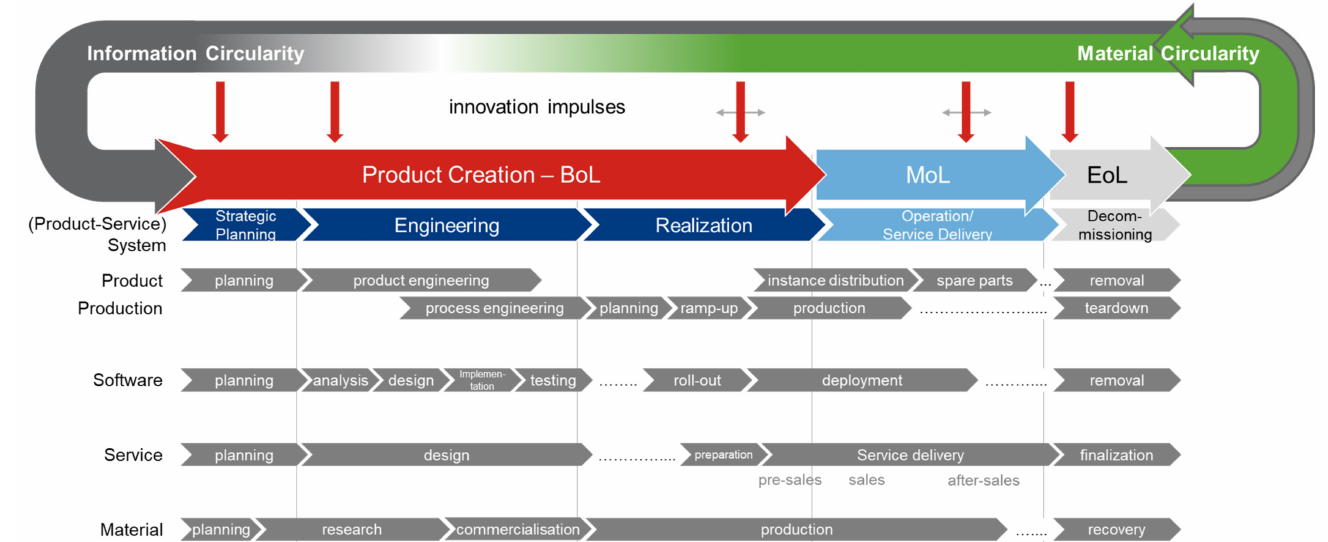
Figure 7. Alignment of technical disciplines and servicing under the hood of the Product Creation process, based on the intrinsic gPLC concept and extended by indications of material and information circularity (linear visualization for the purpose of